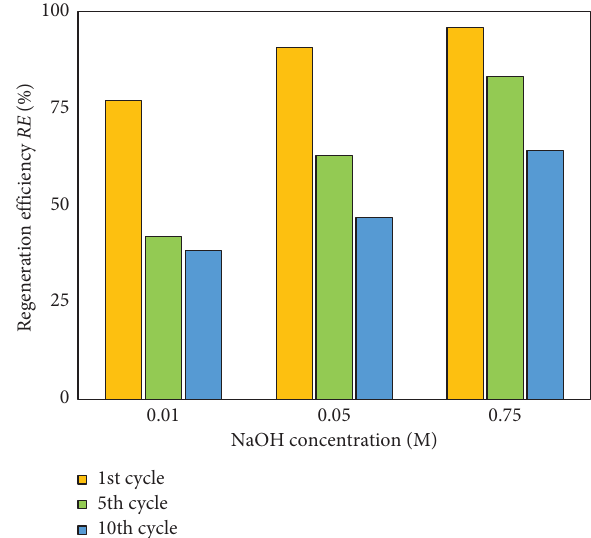
Figure 4: Regeneration efciency of bone char using NaOH